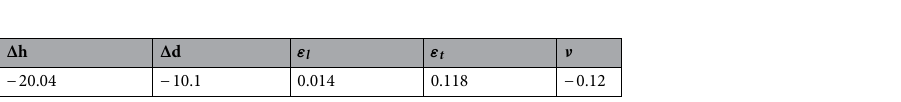
Figure 16. The start (left) and end (right) positions of compression test for the auxetic structure.